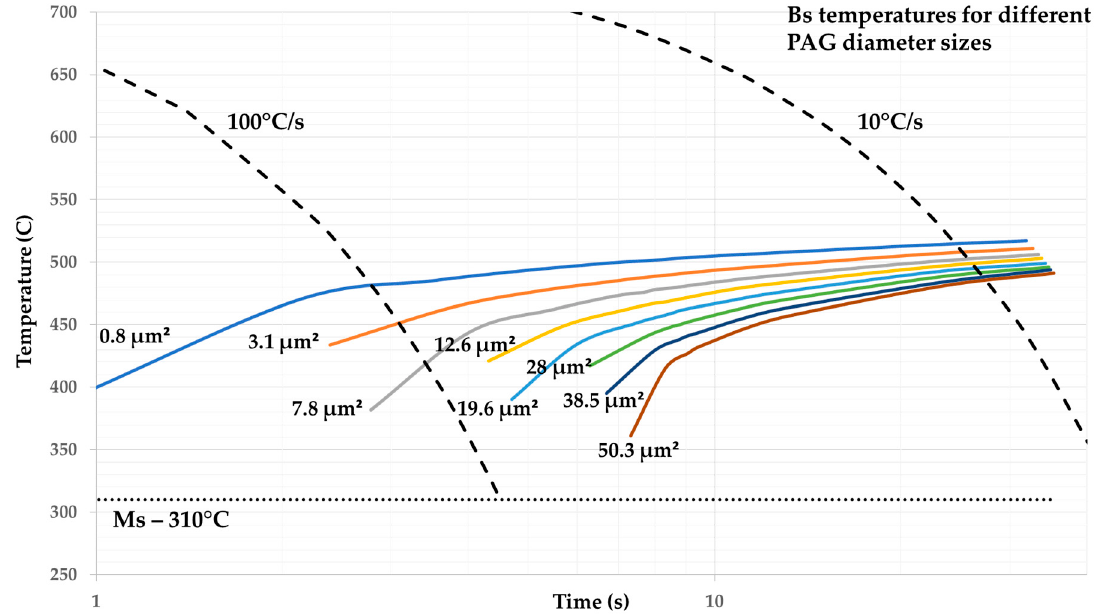
Figure 13. The bainite (B s ) temperature calculated in the continuous cooling transformation (CCT) diagrams [30–32] for variating PAG sizes for the studied chemical composition. For a cooling rate of 65 °C/s, formation of bainite is expected for grains having a size between 1–8 μ m.